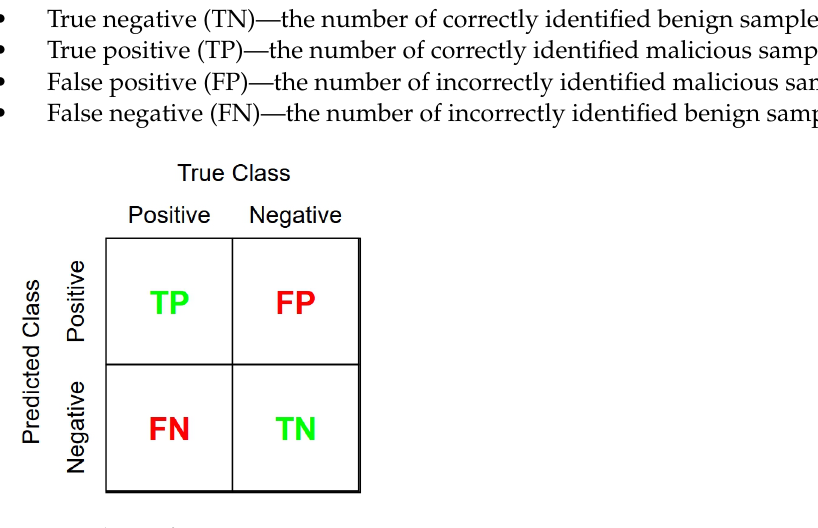
Figure 4. The confusion